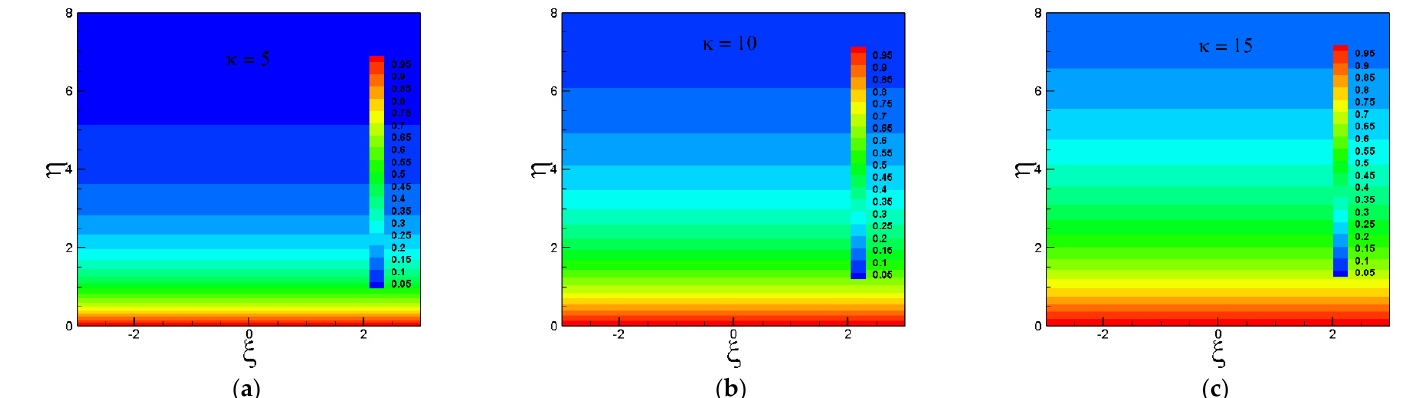
Figure 4. ( a ) Isotherm with 𝜿 = 𝟓 . ( b ). Isotherm with 𝜿 = 𝟏𝟎 . ( c ). Isotherm with 𝜿 = 𝟏𝟓 .